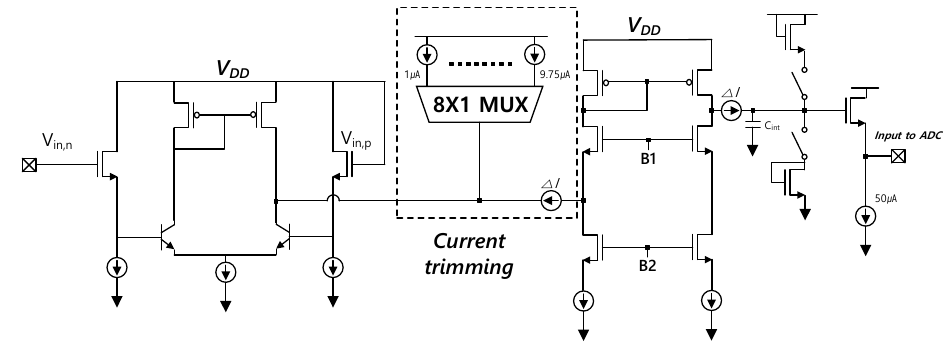
Figure 8. Structure of readout integrated circuit (ROIC)’s charge to current converter.